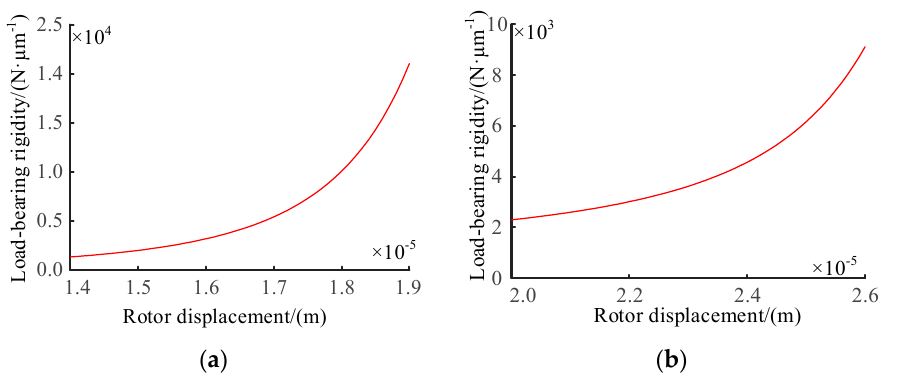
Figure 10. Stiffness-displacement curve. ( a ) is total stiffness of bearing system before oil film thickness change, ( b ) is total stiffness of bearing system after oil film thickness change.